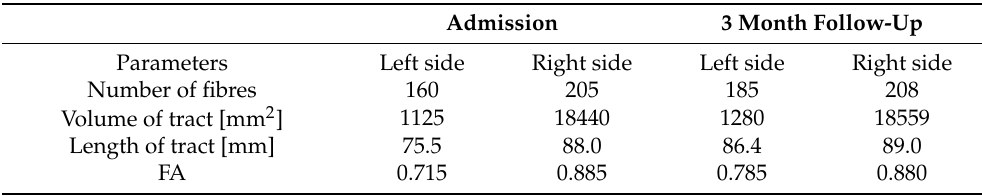
Table 2. The patient’s morphological data of the arcuate fasciculus (AF) upon admission and three months following